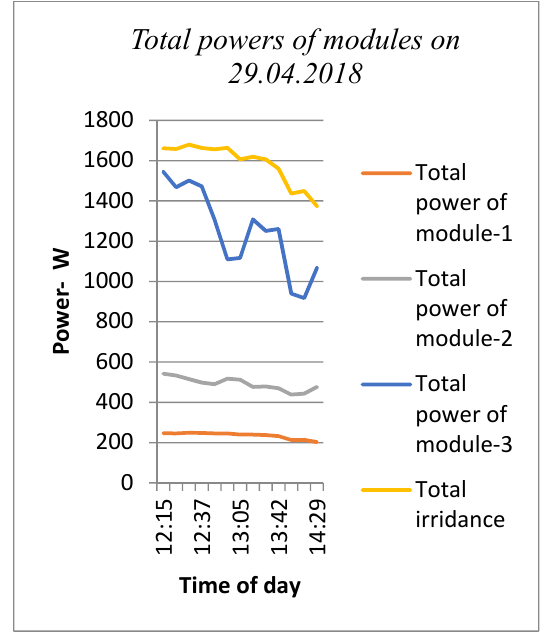
Figure 16. Total powers of modules on 29.04.2018.